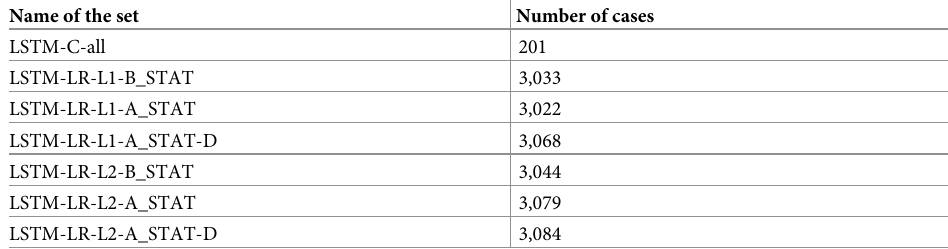
Table 6. Summary of the number of cases correctly predicted by the corresponding baseline model as well as the LSTM+CNN. Name of the